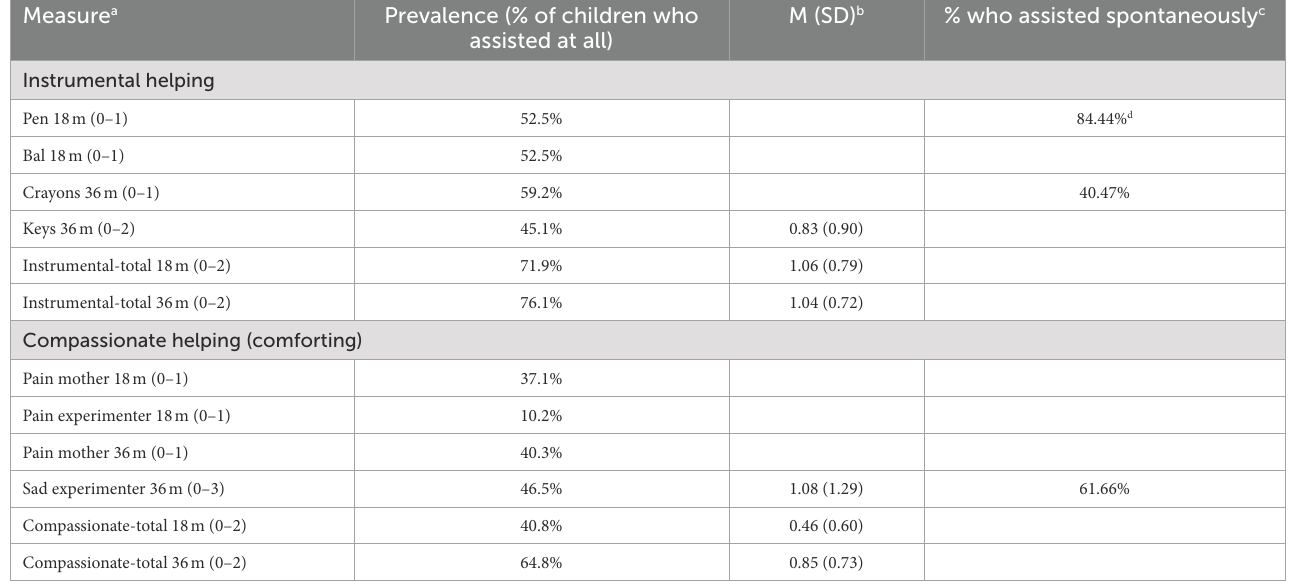
TABLE 1 Descriptive statistics for instrumental and compassionate helping tasks. Measure a